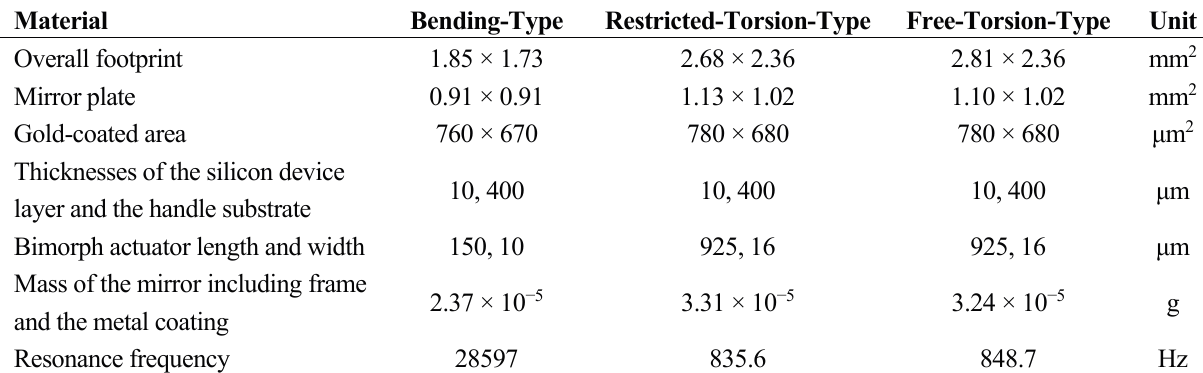
Table 1. Dimensions/parameters for three micromirror designs.